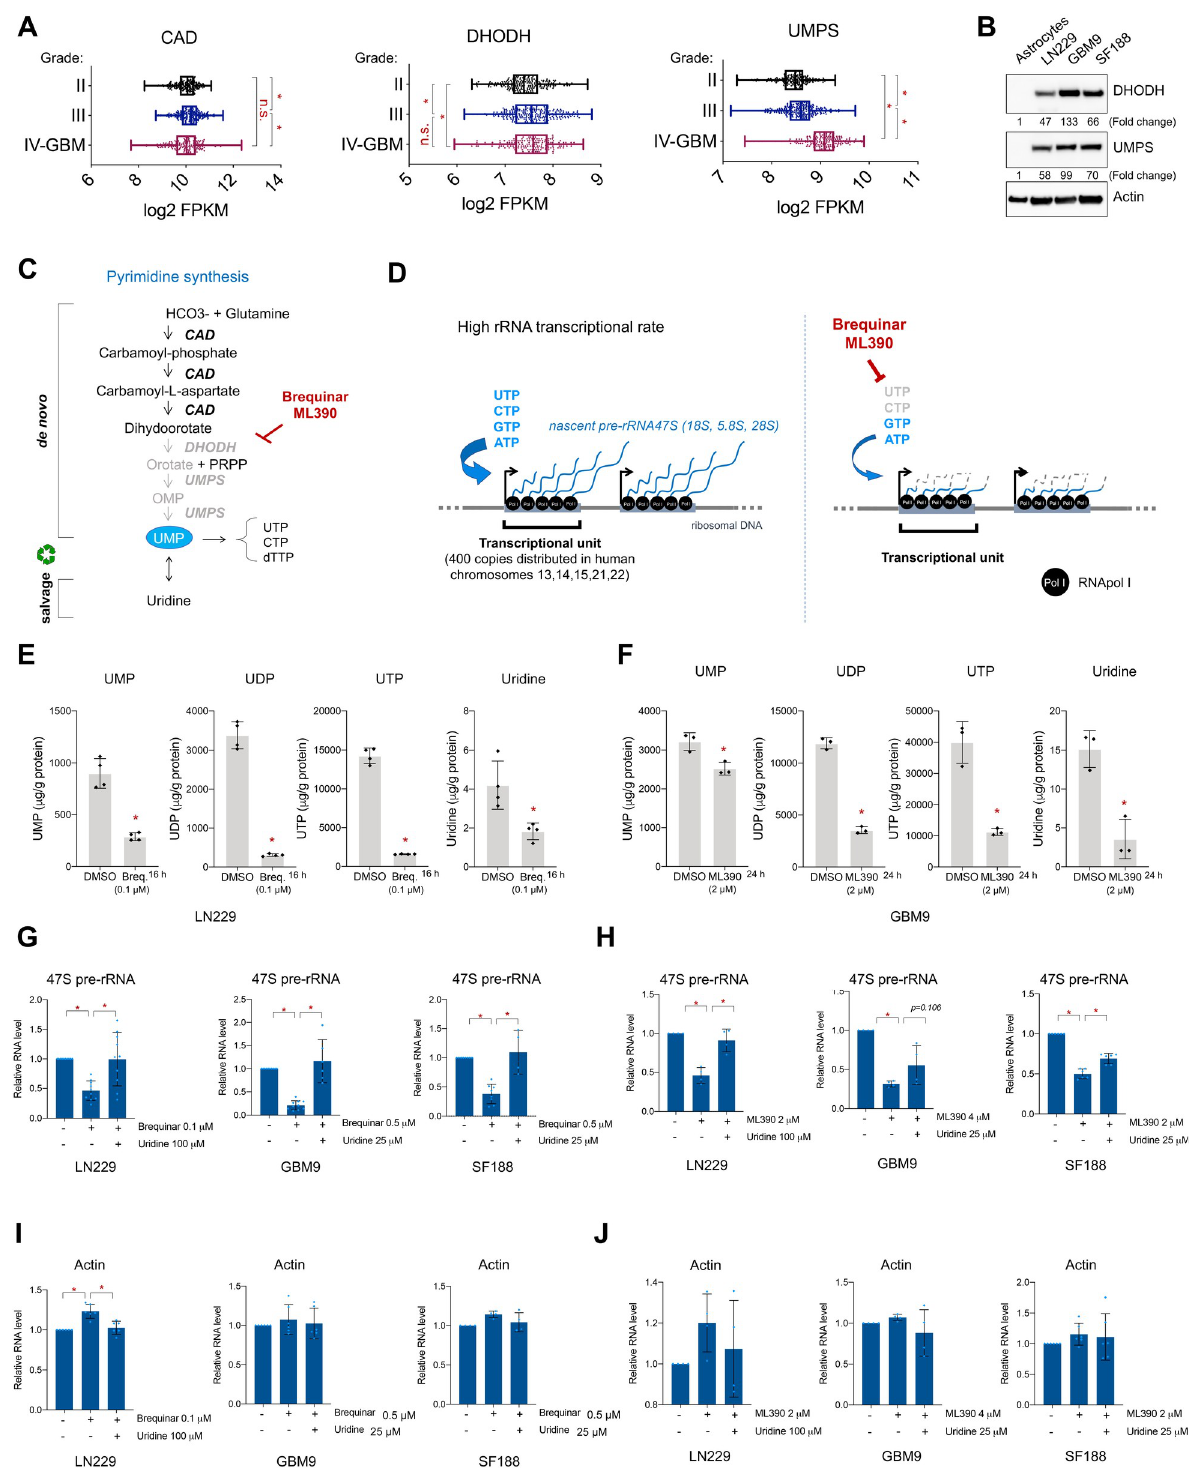
Fig 1. De novo pyrimidine biosynthesis is necessary to maintain efficient ribosomal RNA transcription in glioblastoma. (A) CAD , DHODH and UMPS mRNA levels in lower (II-III) to higher grade (IV/GBM) glioma patients from TCGA database. (B) Western blot of p14 ARF-/- human astrocytes, LN229, GBM9, and SF188. Fold change in expression as indicated was normalized to actin levels and compared to the expression in astrocytes by densitometry analysis with Image J. (C) Representation of de novo and salvage pyrimidine biosynthesis pathways and brequinar. (D) Representation of the high rDNA transcription rate (left panel) and the potential effects of blocking the de novo pyrimidines biosynthesis (right